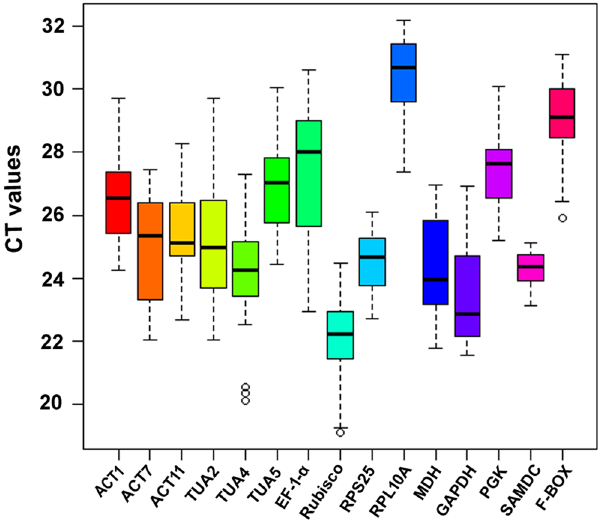
Figure 1. Distribution of threshold cycle (CT) values of 15 candidate reference genes across all 22 samples. The solid line within each box represents the 50th percentile. The lower boundary and upper boundary of each box represents the 25th and 75th percentile, respectively. The circles represent potential